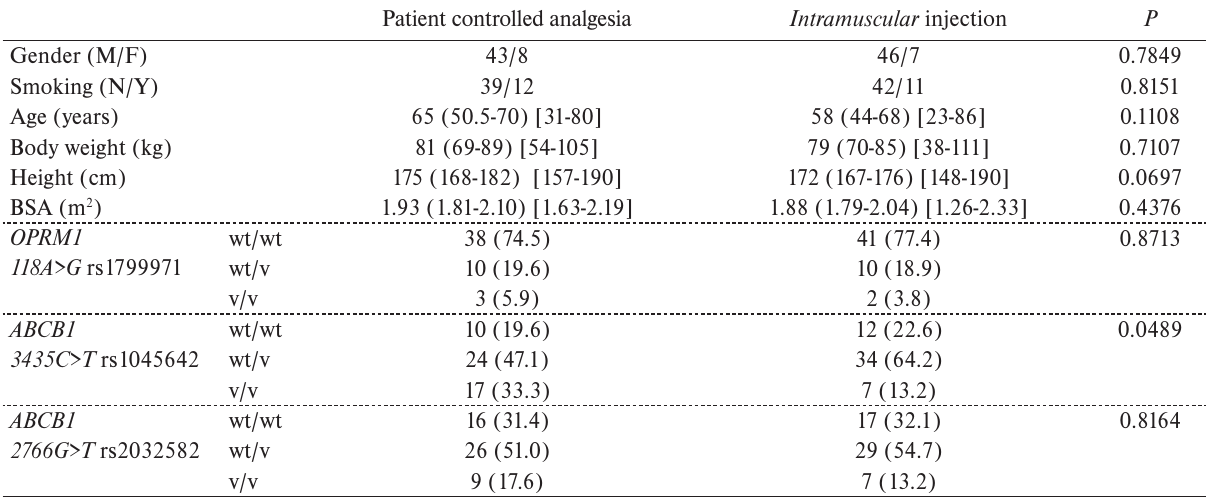
Table 1. Patient characteristics; genotype frequencies of OPRM1 (rs1799971) and ABCB1 (rs1045642, rs2032582). Patient controlled analgesia Intramuscular